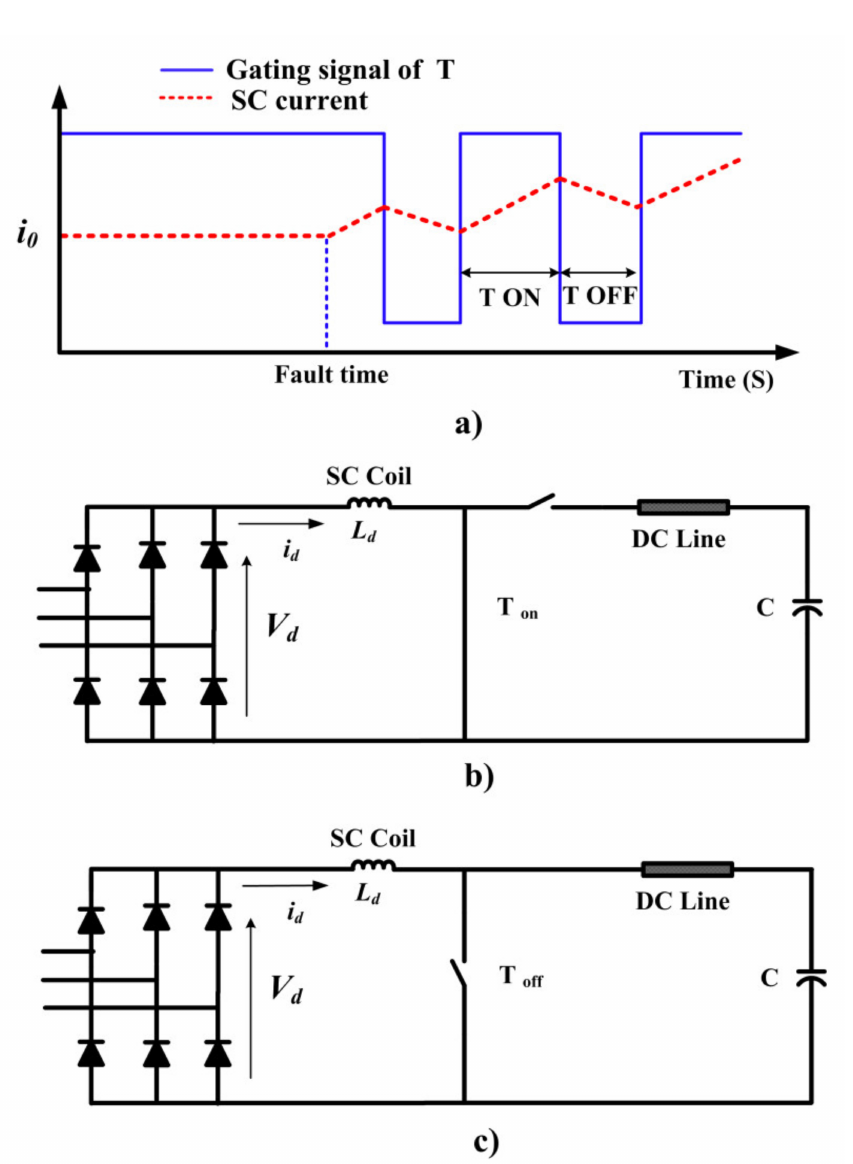
Figure 5. Operation of chopper in the fault condition, ( a ) gating signal of T, ( b ) T is ON, and ( c ) T is OFF. Control